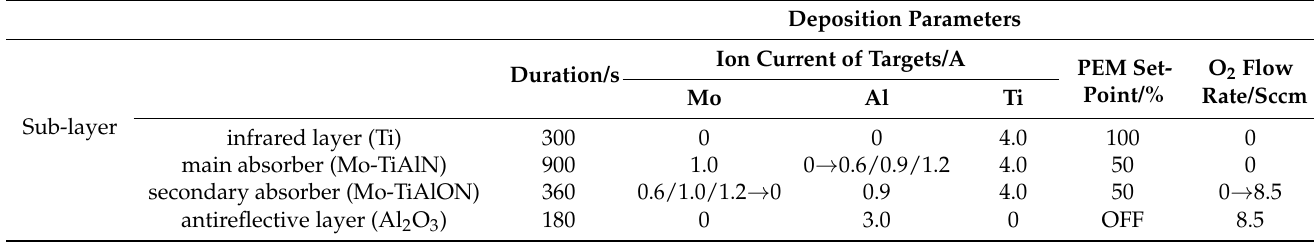
Table 1. Process parameters for depositing Ti/Mo-TiAlN/Mo-TiAlON/Al 2 O 3 film.